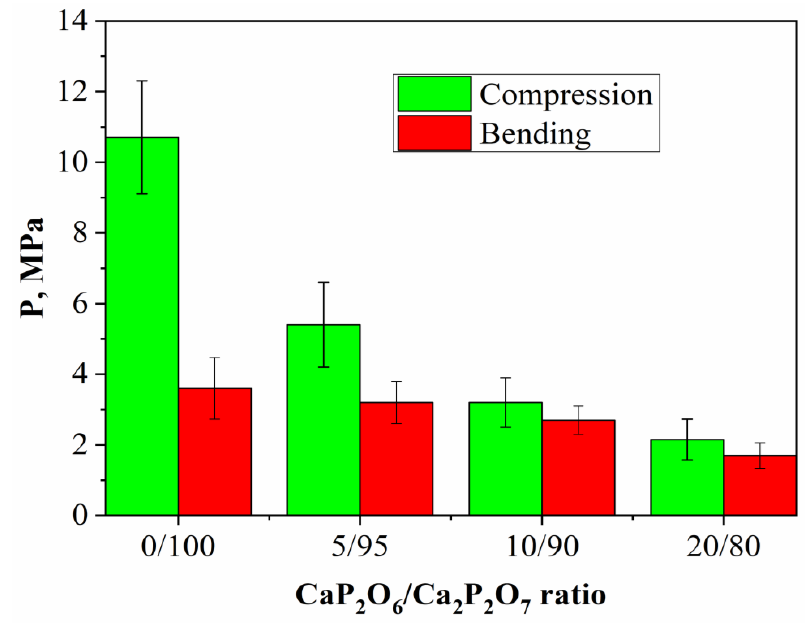
Figure 5. The compressive and bending strengths of the cement-salt stone with the weight ratio of: Ca(PO 3 ) 2 /Ca 2 P 2 O 7 = 0/100; Ca(PO 3 ) 2 /Ca 2 P 2 O 7 = 5/95; Ca(PO 3 ) 2 /Ca 2 P 2 O 7 = 10/90; Ca(PO 3 ) 2 /Ca 2 P 2 O 7 = 20/80.